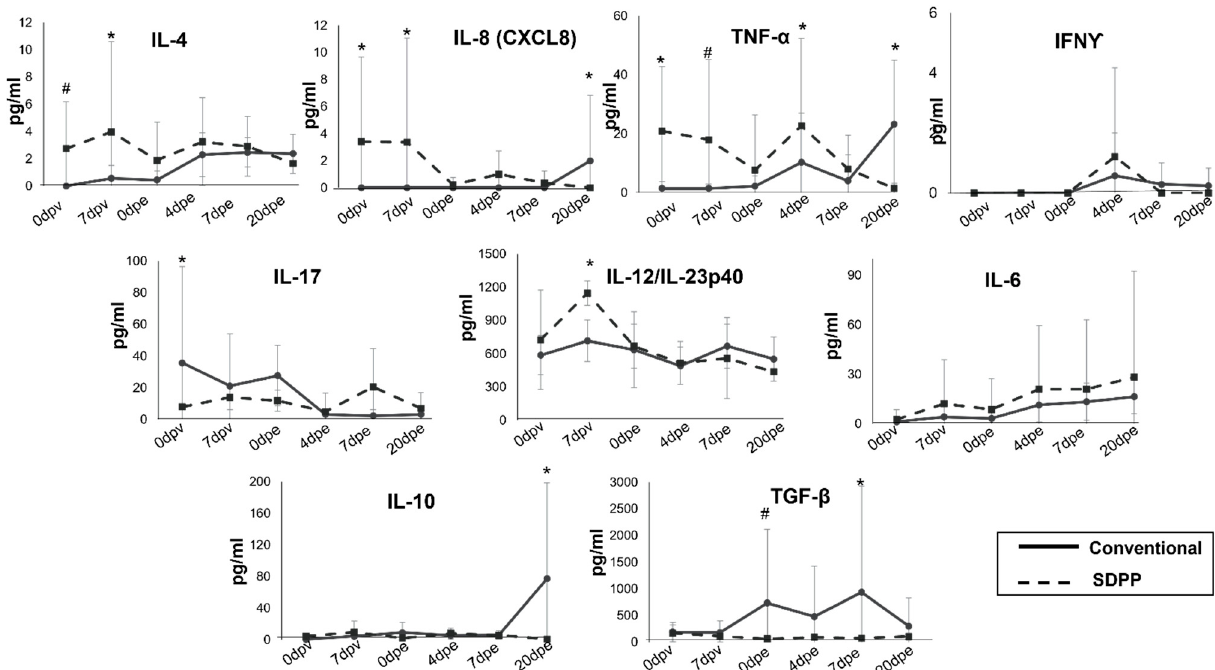
Figure 6. Serum concentrations of several cytokines quantified by Luminex after 24 days of diet acclimation (before immunization). * = p < 0.05; # = p < 0.1.